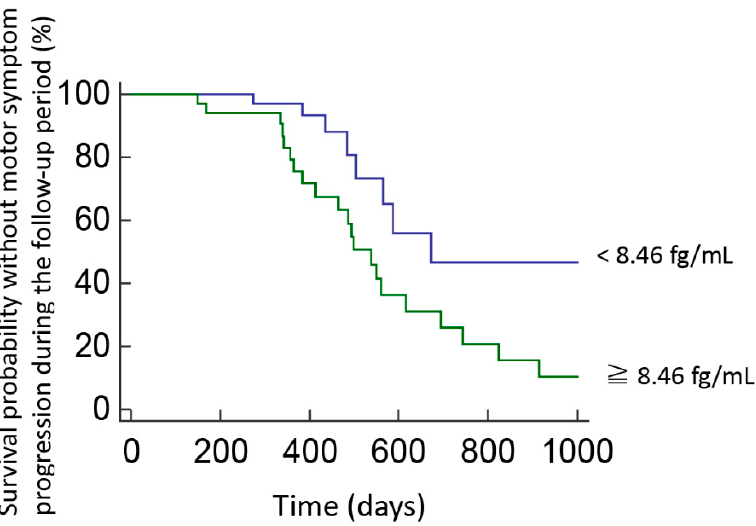
Figure 4. Survival probability without motor symptom progression in PD patients with high or low plasma pS129- α -synuclein levels during follow-up. Kaplan–Meier plots show survival probability without motor progression in patients with PD who had baseline pS129- α -synuclein concentrations above or below the cut-off levels determined in ROC analyses. Motor progression was defined as a sustained increase of at least 3 points in the MDS-UPDRS part III score at follow-up.